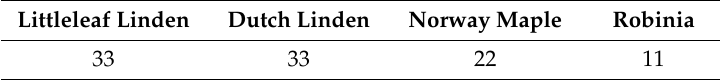
Table 3. Training sample size of tree species classification by ALS data.